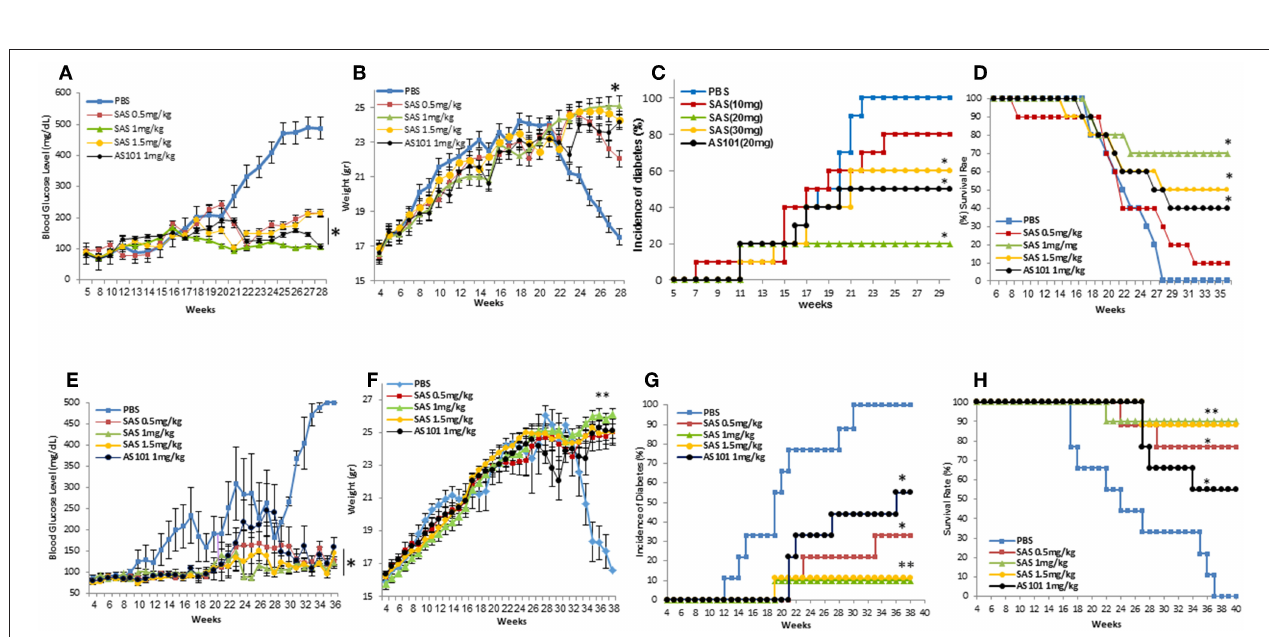
FIGURE 7 | Treatment of NOD mice with SAS or AS101 decreases clinical symptoms of T1D in NOD mice. SAS at different concentrations or AS101 at 1 mg/kg/injection were administered i.p. every other day to female NOD mice, starting at either 5–6 weeks of age (A–D) , or at 3 weeks of age (E-H) until 30 weeks. Blood glucose levels (* p < 0.005 decrease vs PBS) (A,E) , body weight (** p < 0,001; * p < p < 0.005 increase vs. PBS) (B,F) , percent incidence of diabetes (* p < 0.005 decrease vs. PBS; ** p < 0.001) (C,G) , and survival (* p < 0.005 increase vs. PBS) (D,H) were monitored. N = 10 mice/group.